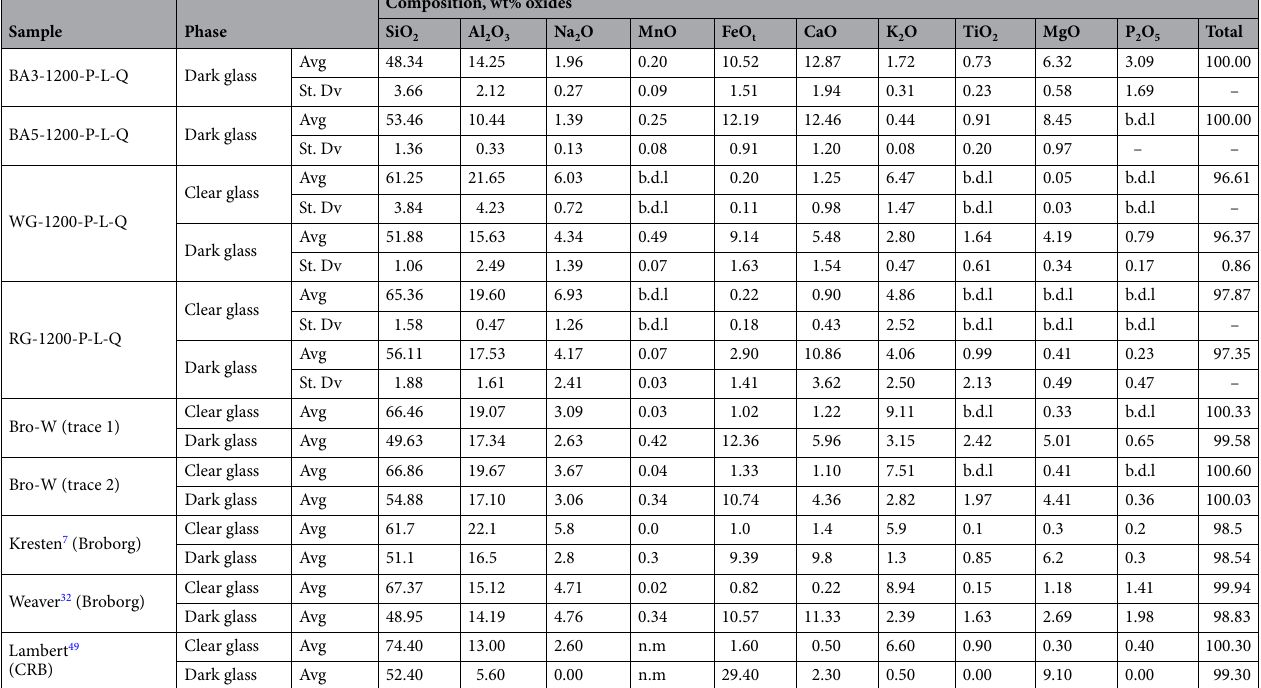
Table 1. Elemental composition (wt% oxides) of various glasses measured in the heated amphibolites (BA3, BA5) and granitoids (WG, RG), as well as an archaeological sample (Bro-W). n.m. indicates not measured; b.d.l. indicates below detection limits. For the archaeological samples, the reported values are those at the ends of the trace at the interface between dark and clear glass (see Table S2). Fe oxide for all shown as FeO t , with no assumption about oxidation state. For interpretation of sample names, refer to “Methods”